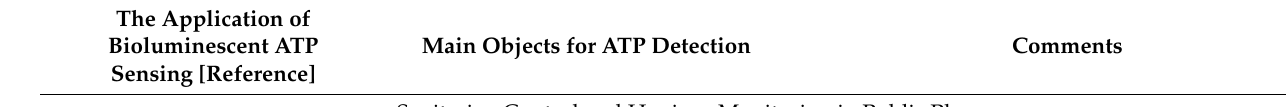
Table 1. Main recent directions of bioluminescent ATP-based chemosensing